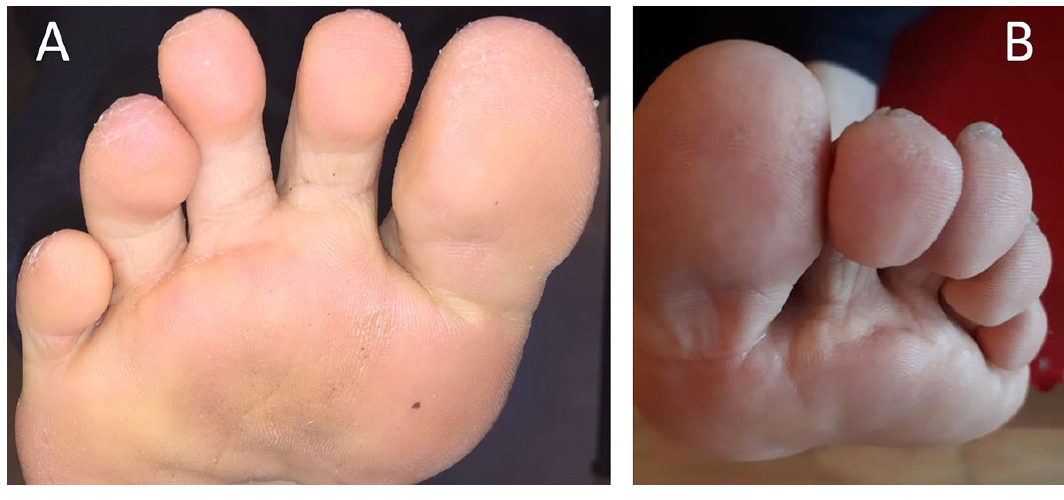
Figure 5: Representative scar samples at a mean of 7.9 years follow up in two different patients. A third web space, B second web